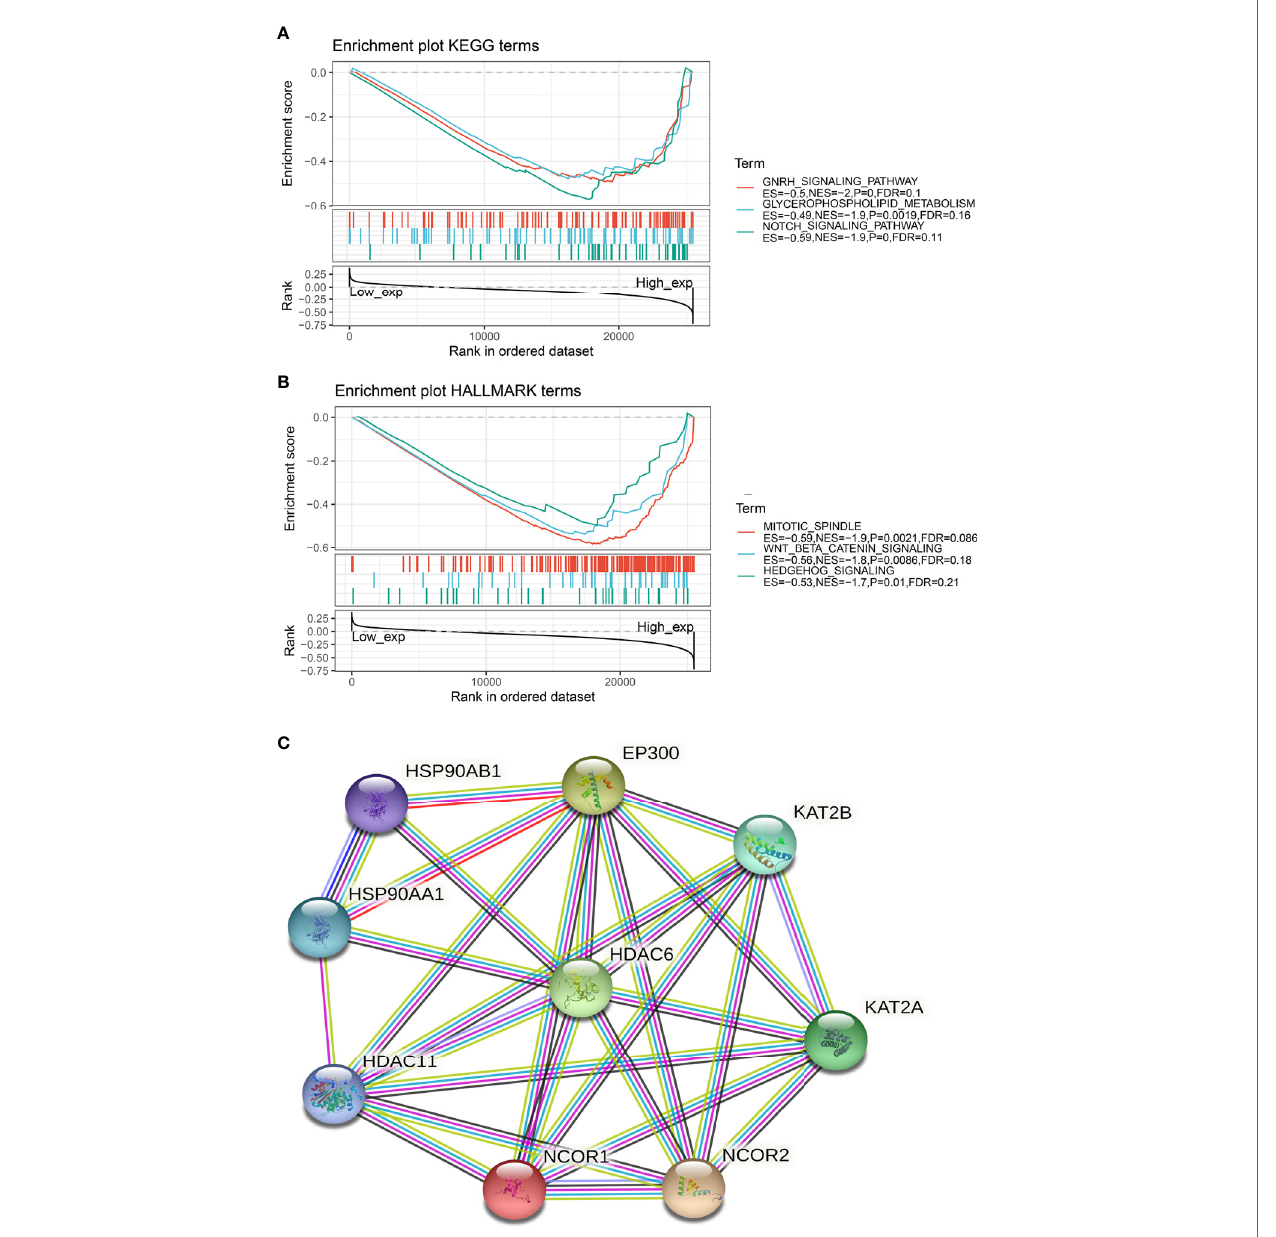
FIGURE 6 | Signaling enrichment of HDAC6 in KEGG and markers. (A) GSEA analysis of the top three correlations of HDAC6 with signaling pathways in the KEGG database. (B) GSEA analysis of HDAC6 with the top three results of signaling pathway correlations in the marker dataset. (C) String constructs HDAC6 protein co- expression